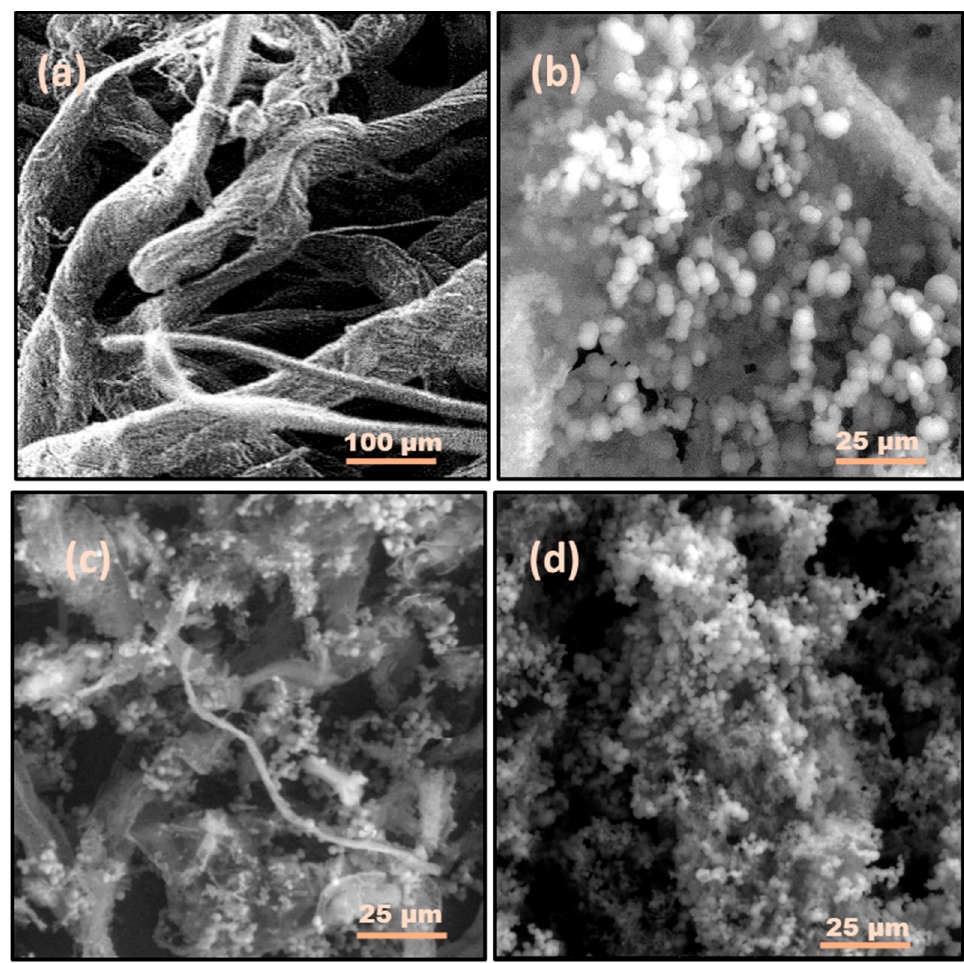
Figure 4. SEM images of ( a ) Raw Holocellulose (HC) and corresponding carbon micro-spheres: ( b ) HC-200, ( c ) HC-250, and ( d ) HC-300 produced at various temperatures.